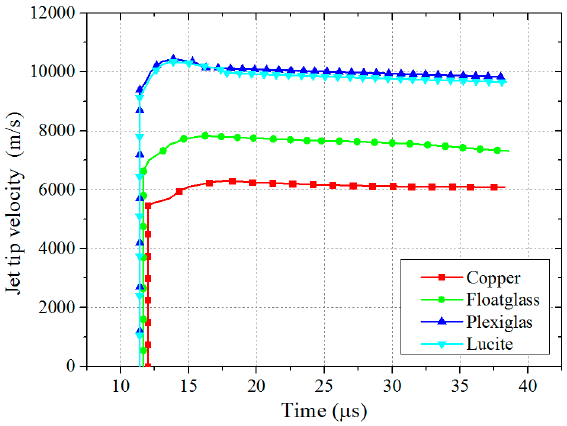
Figure 3. Jet tip velocity corresponding to the four different liner materials.